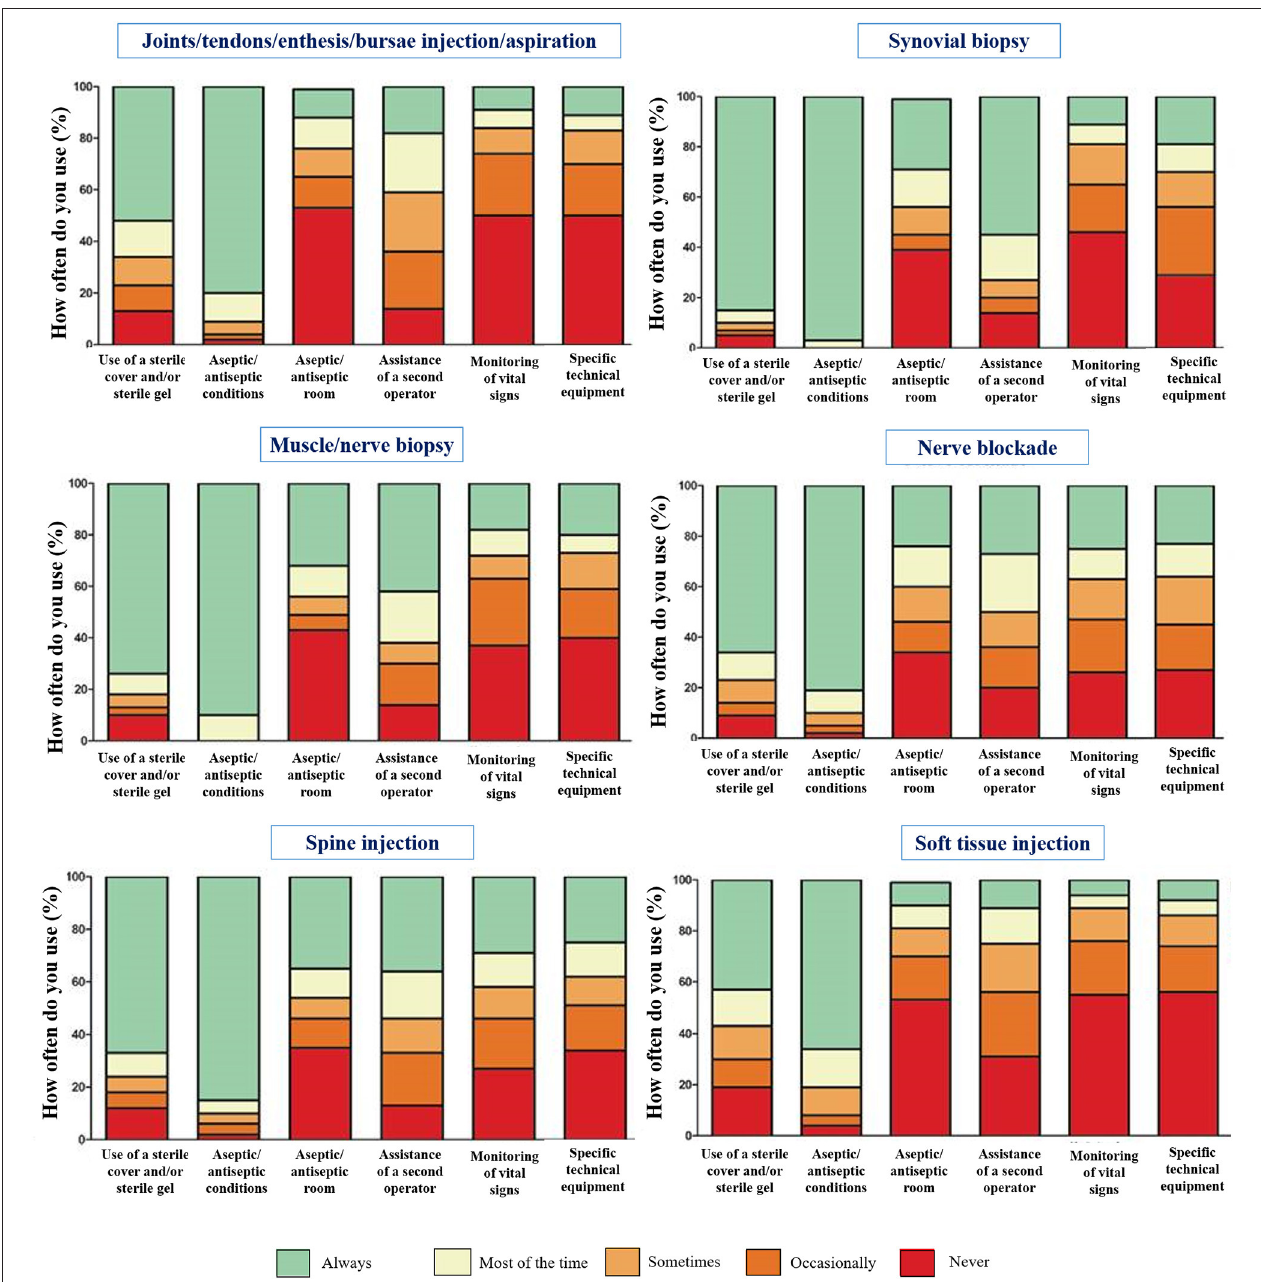
FIGURE 2 | Frequency of use of different preparations and procedural steps in respondents performing interventional procedures according to site and type of interventions.